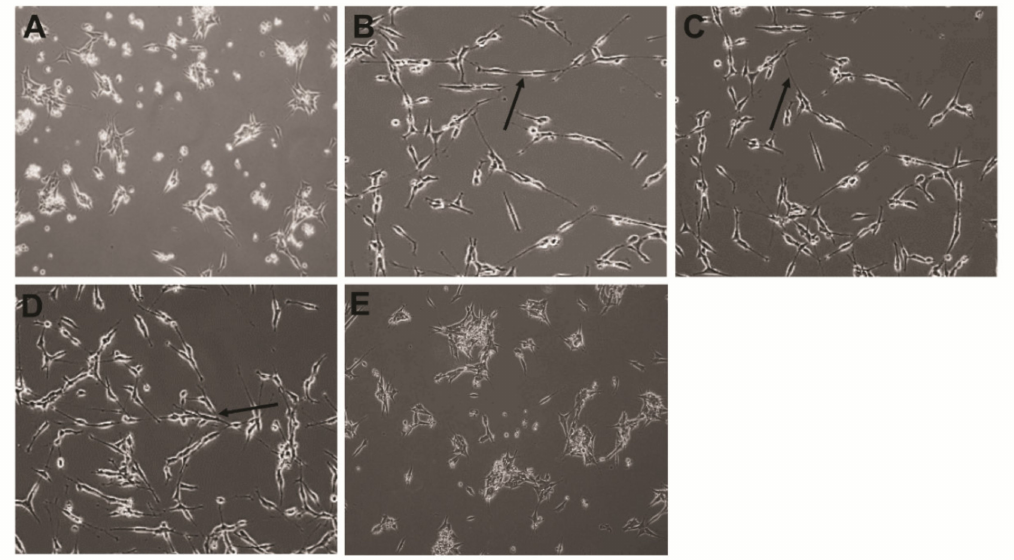
Figure 11. ( A ). PtNPs and RA enhance the di ff erentiation and expression of di ff erentiation markers of SH-SY5Y cells. SH-SY5Y cells were incubated with PtNPs (25 µ g / mL), RA (12.5 µ M), combination of PtNPs (25 µ g / mL) and RA (12.5 µ M), or cisplatin (6.5 µ M) for 24 h. Phase contrast microscopy images showing the morphological changes in SH-SY5Y cells after treatment without ( A ) and with PtNPs ( B ), RA ( C ), PtNPs and RA ( D ), and cisplatin ( E ) in 1% serum-supplemented medium. The black arrows indicate significant, lengthy neurite outgrowth. At least three independent experiments were performed for each sample. Scale bar is 100 µ